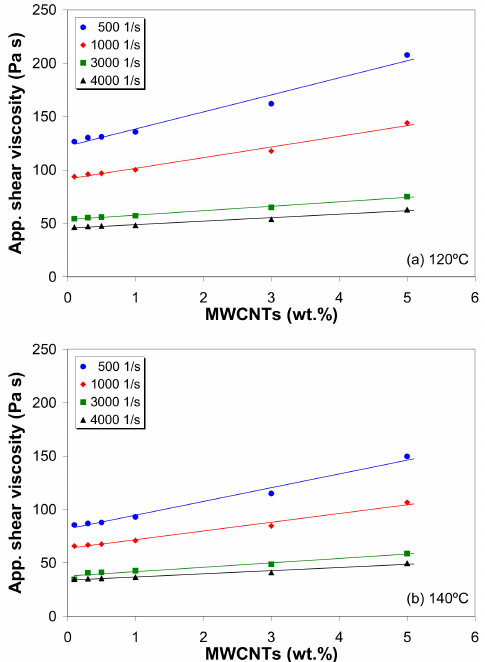
Figure 7. Relationship between apparent shear viscosity and MWCNT loading at ( a ) 120 ◦ C and ( b ) 140 ◦